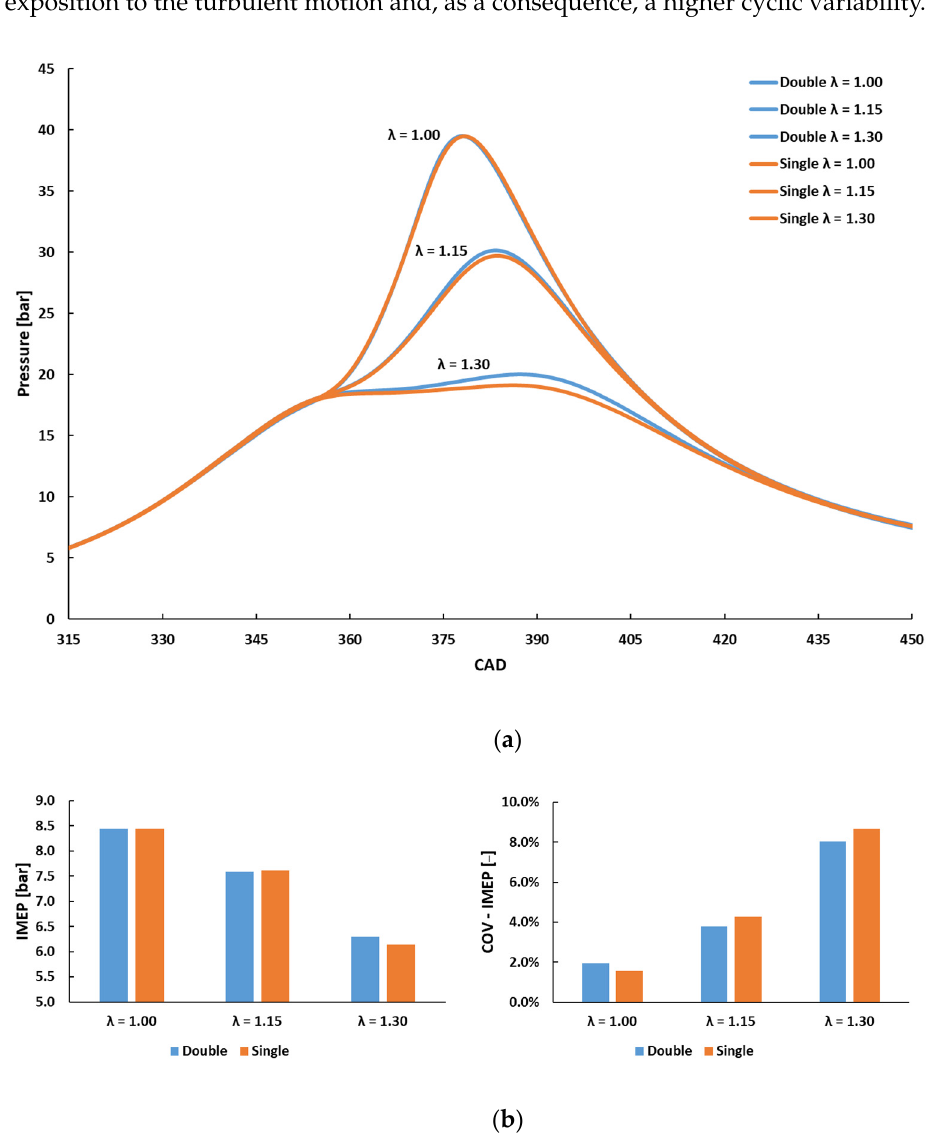
Figure 5. ( a ) In ‐ cylinder pressure traces (top) and ( b ) mean IMEP and COV values for both spark plug designs and cross ‐ flow orientation (AFR rel 1.00–1.15–1.30, SA 12 CAD). The double ‐ electrode spark plug allowed reaching slightly higher peak pressures (i.e., about 0.3 and 1.0 bar difference for AFR rel 1.15 and 1.30, respectively), except for the